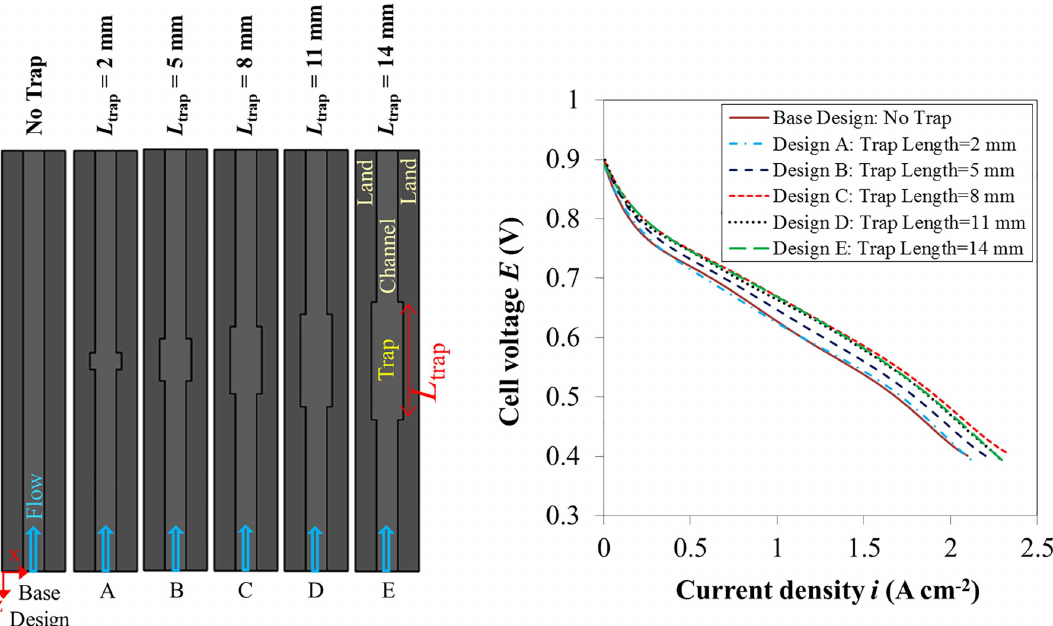
Figure 18. Study of the effect of traps and their lengths on the cell performance: the left picture shows (mono-trap or single-trap) channels with the different trap lengths of 2, 5, 8, 11, and 14 mm, here named as Cases or Designs A, B, C, D, and E, respectively, and the simple straight (conventional) channel called the base design (the channel with no trap). The shown graph compares the polarization curves for these PEMFC Designs A to E and a PEMFC with no-trap straight (conventional) channel (base design)